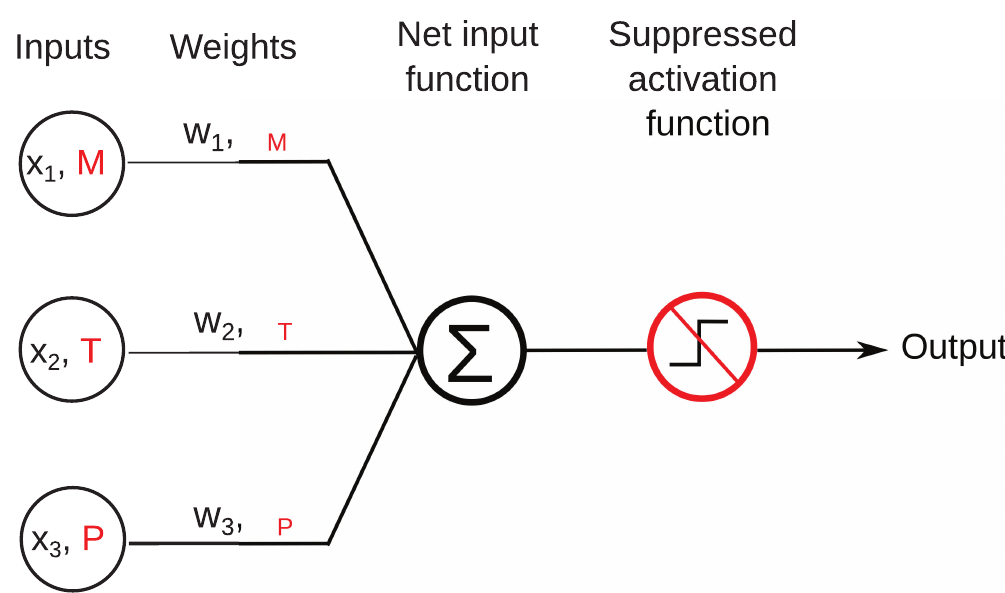
Fig 2. SLP ANN schematics. The usual ANN notation is in black text and in red text, the equivalent terms corresponding to this particular work are shown. (See Eq 1). The element-wise product between the inputs and the weights are added up in the “net input function” stage and suppressing the activation function, an output corresponding to the linear combination of the inputs and the weights is obtained.